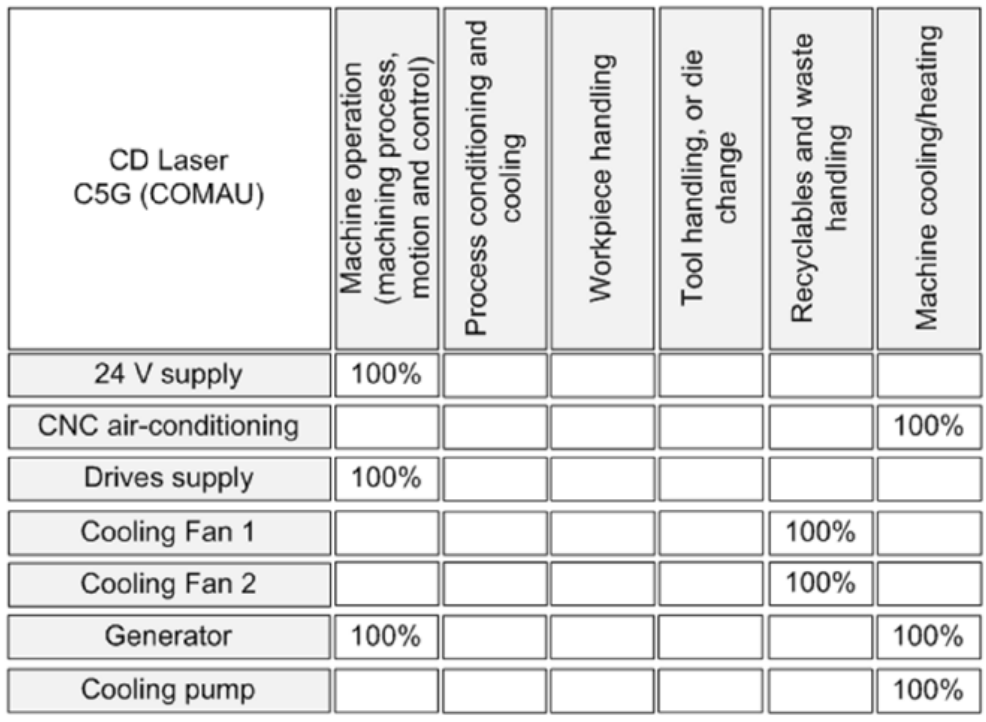
Figure 4. Cluster matrix for functional analysis according to ISO 14955 [19].